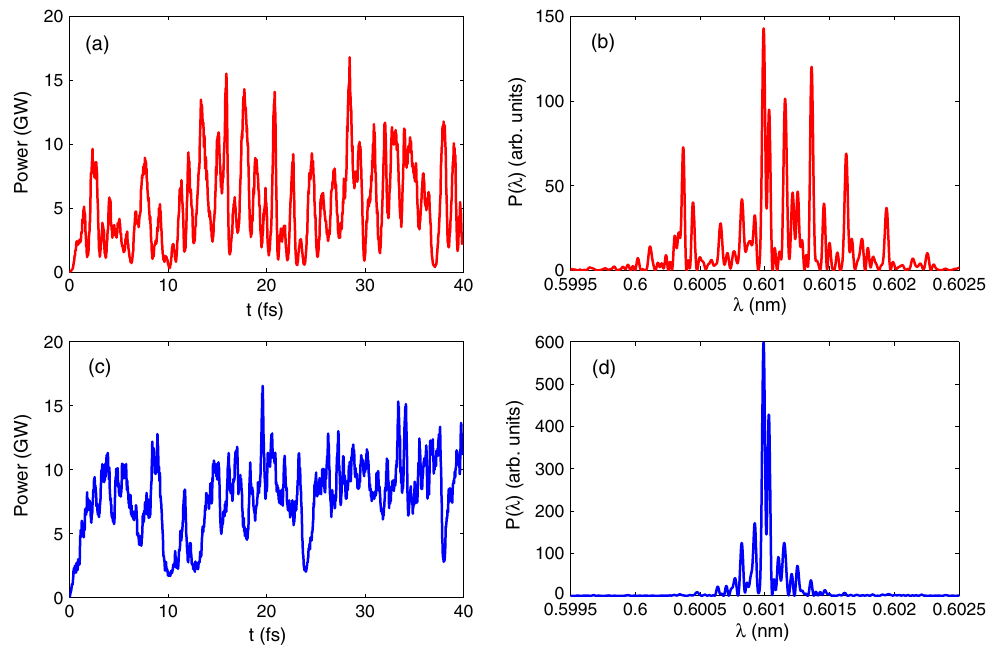
FIG. 6. Representative radiation power profiles and spectra for a standard SASE FEL [(a) and (b)] and a pSASE FEL [(c) and (d)]. The average power for both cases is about 7 GW and in the simulation the beam parameters, lattice functions, and initial shot noise are all the same. The spectral brightness is normalized to the peak spectral brightness at the exit of